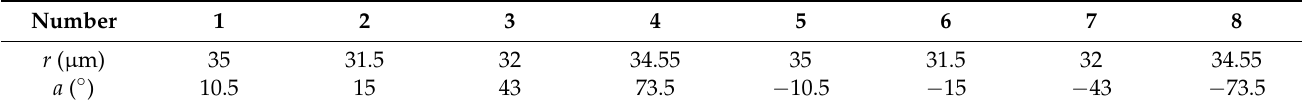
Figure 1. ( a ) Schematic of the proposed beam splitter combined with the optically controlled scheme. ( b ) Partial detailed view of the beam splitter. The dashed frame denotes the basic unit (A + B). ( c ) The geometrical parameters of an SRR. ( d ) Schematic of the multilayered structure. Table 1. Geometrical parameters of the eight SRRs forming the supercell